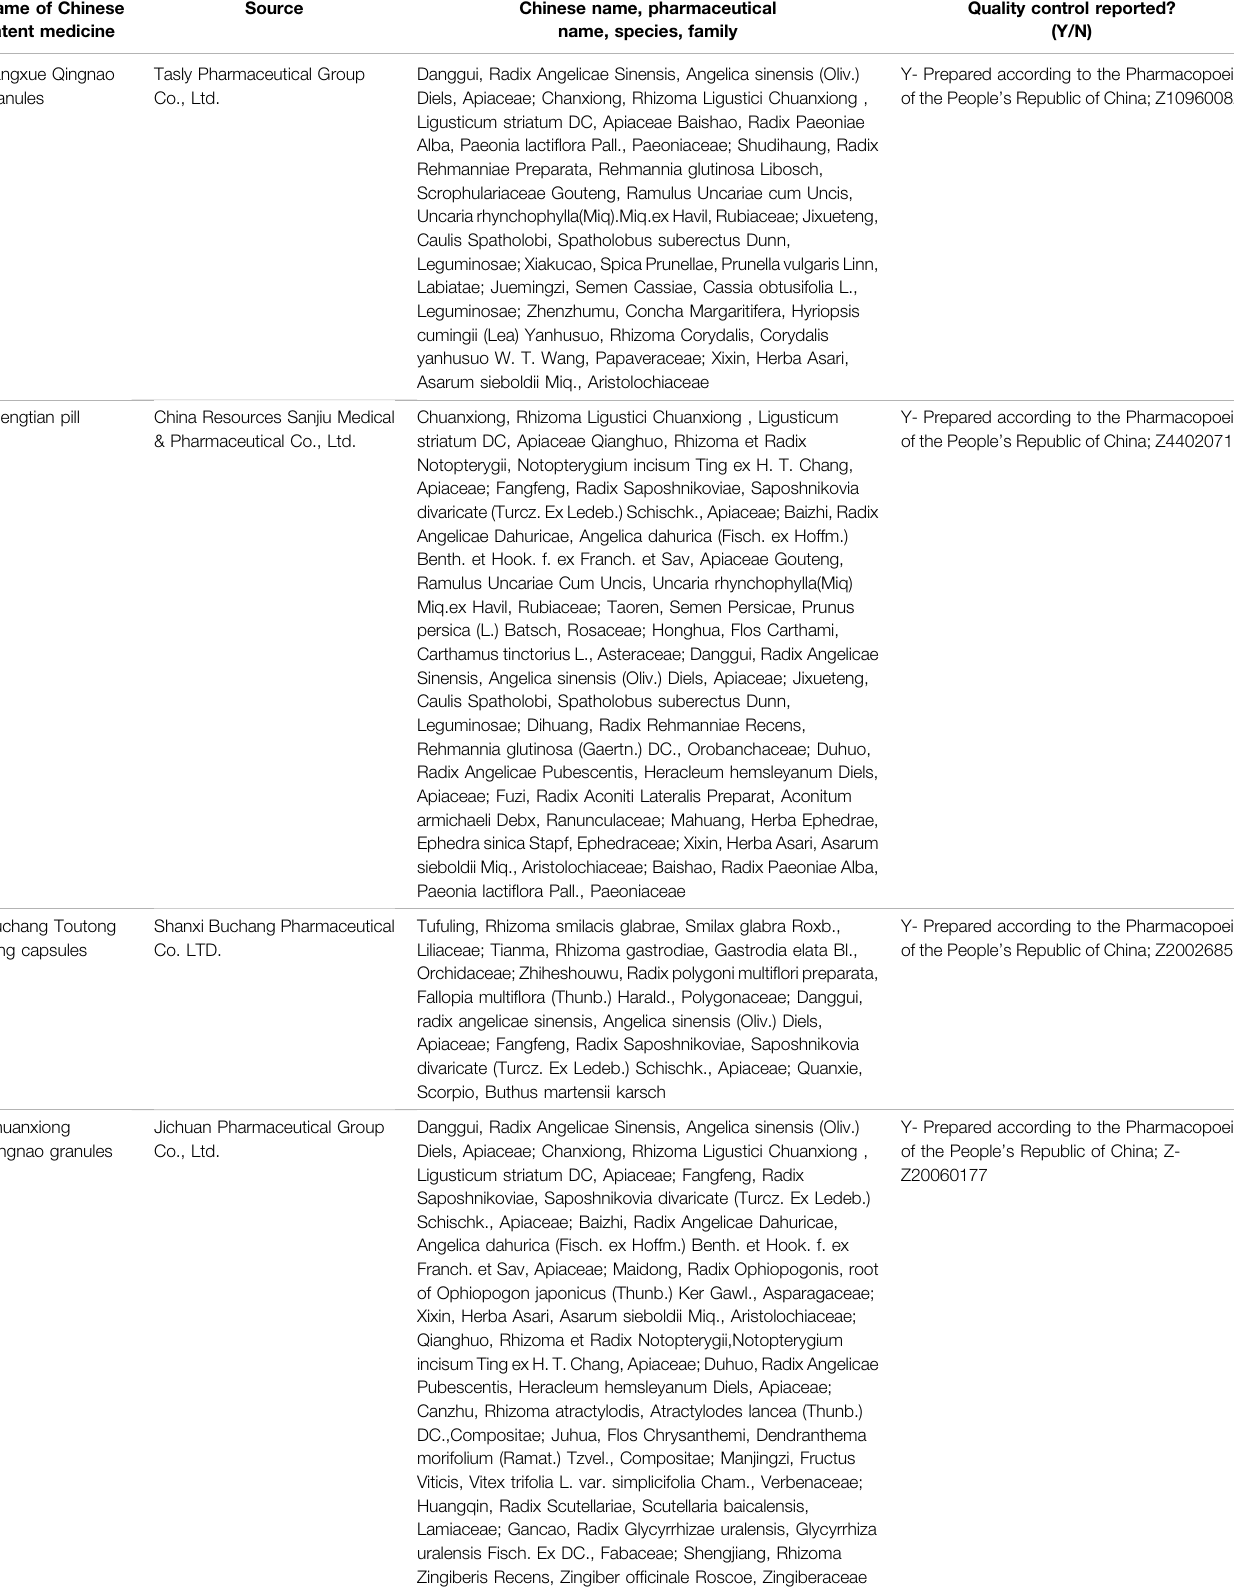
TABLE 4 | Composition of Chinese patent medicines used in the included studies. Name of Chinese patent